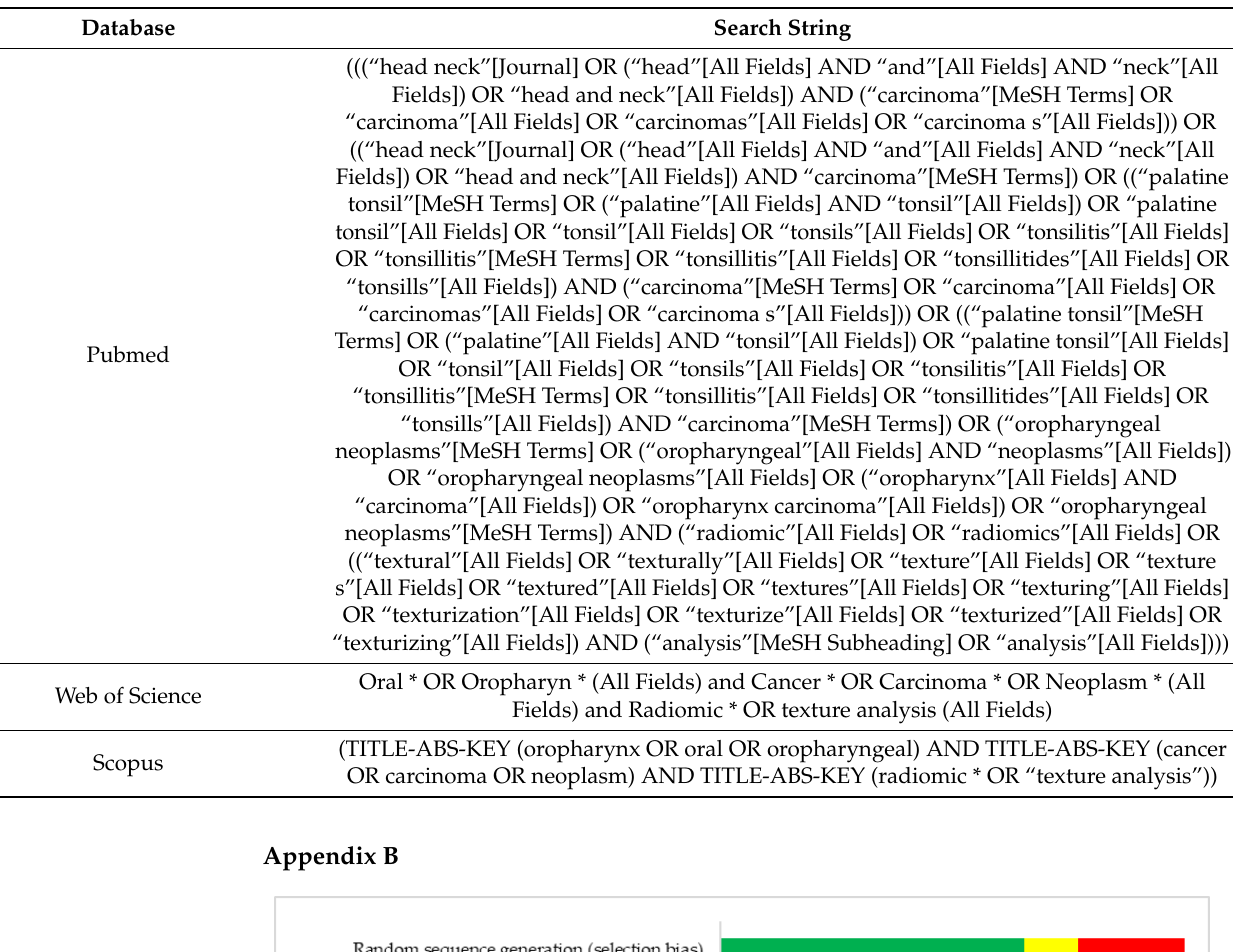
Table A1. Search strings used.